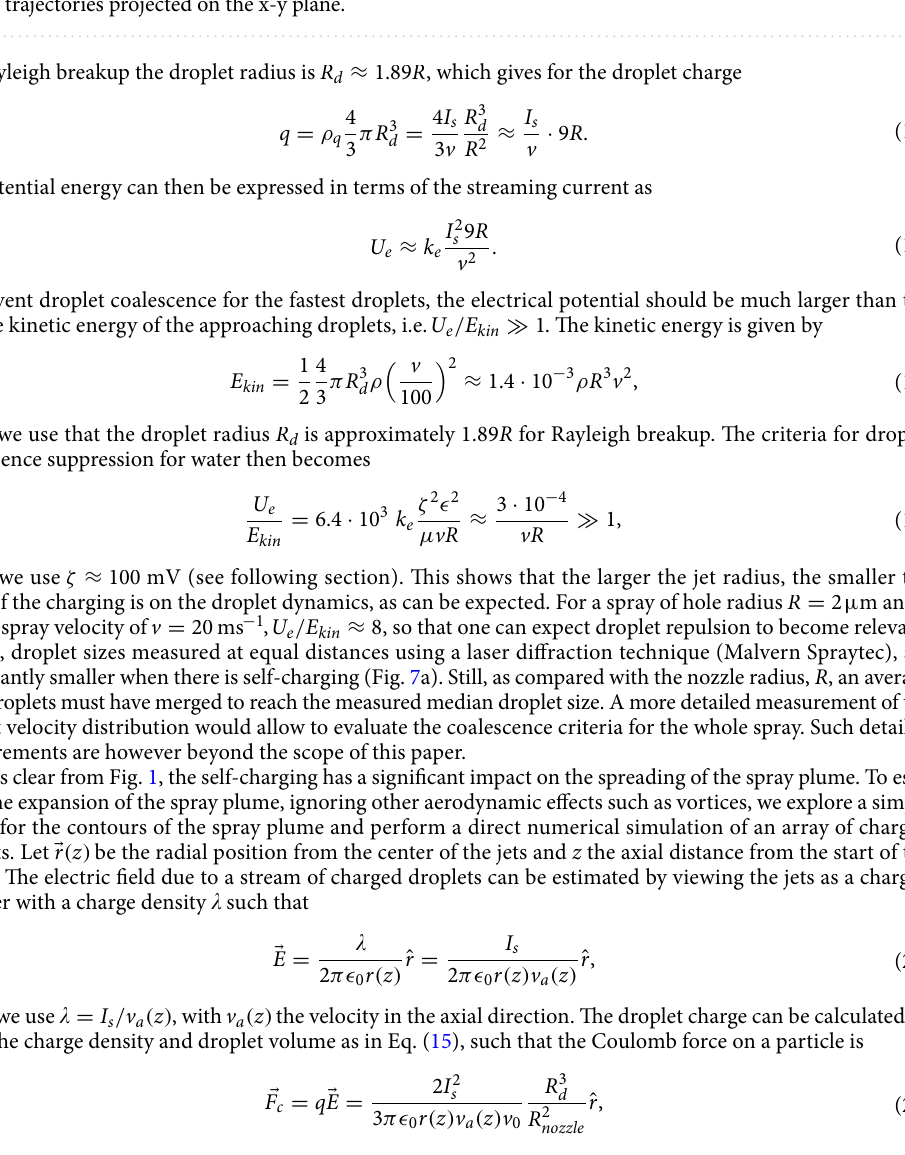
2 µ m spray nozzle, i.e. 8 holes of radius 2 µm, and numerical R Figure 7. Measured droplet size of a 8 × = models for the expansion of the spray cloud due to self-charging. ( a ) droplet size distributions measured with 2 µ m spray nozzle at a distance of approximately 0.05 m from laser diffraction (Malvern Spraytec) for a 8 × the nozzle, with and without self-charging (see also Fig. 1). Sodium chloride is added to produce uncharged droplets. Droplet sizes are smaller in the case of self-charging, though droplet coalescence is not completely prevented. ( b ) the predicted divergence of the spray cloud according to Eq. (22). ( c ) numerical simulation of 200 droplet trajectories projected on the x-y